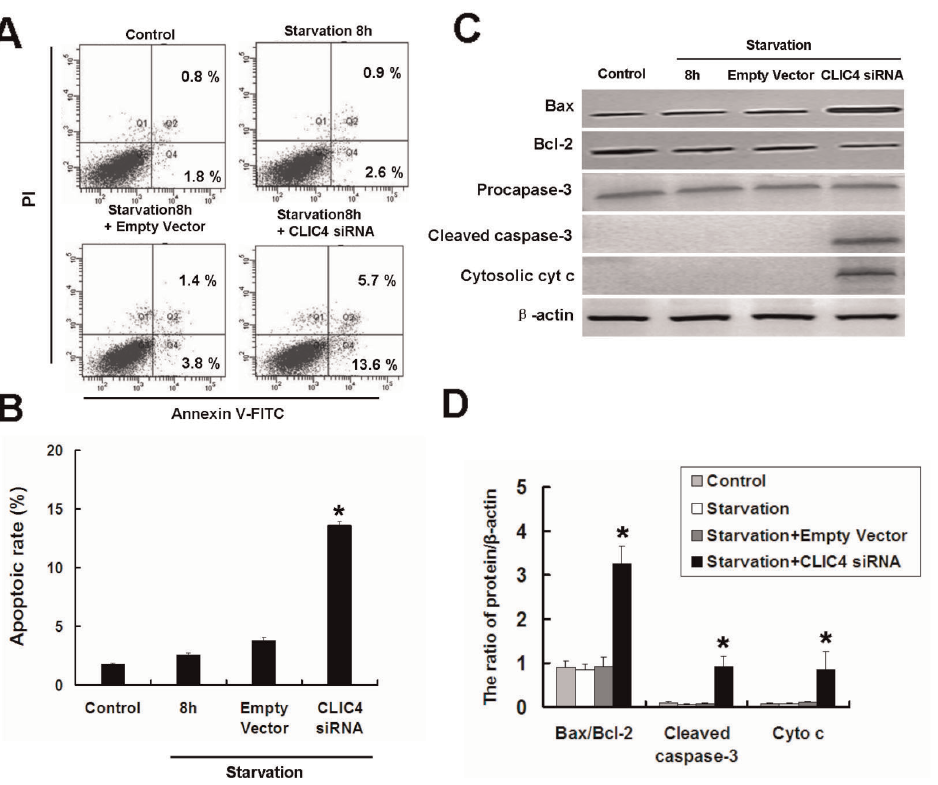
Figure 6. Inhibition of CLIC4 by siRNA triggered apoptosis under starvation conditions in U251 cells. U251 cells transfected with a plasmid encoding empty vector or CLIC4 siRNA vector for 24 h. (A) and (B) U251 cells incubated with EBSS for 8 h, then stained with PI and Annexin V-FITC to determine apoptotic rate. Data were presented as mean 6 SD, n=3. (C) Western blot analysis of Bax, Bcl-2, Cleaved caspase-3 and Cytosolic cyt c expression in U251 cells treated by EBSS for 8 h. (D) Densitometric analysis of normalized Bax/Bcl-2, Cleaved caspase-3 and cyt c levels. Standard error represents three independent experiments. * P , 0.05 versus starvation 8 h group.